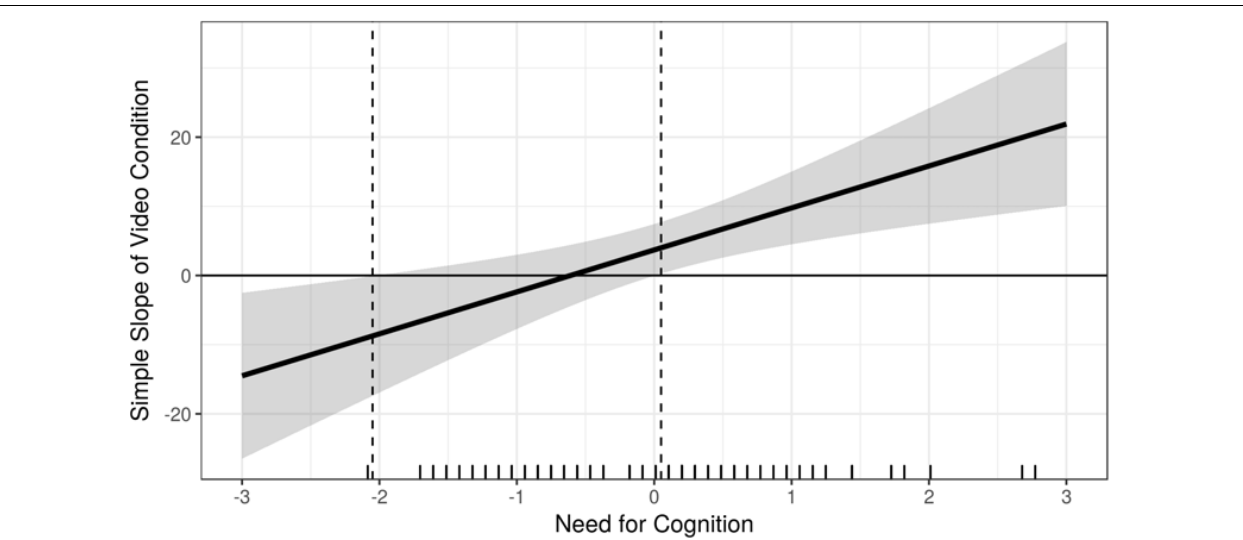
FIGURE 6 | Marginal effects (or regions-of-significance) plot: On the y -axis we depicted the simple slope of video condition on dictator game generosity. On the x -axis we z -transformed Need for Cognition for the purpose of this figure. The simple slope is significant and negative when NFC is –2.05 standard deviations away from the mean or further. 0.85% of observations in NFC are within this region. The simple slope of the elevating video condition on dictator game generosity is significant and positive when NFC is 0.05 standard deviations away from the mean or further. 38.98% of observations in NFC are within this region. The results depicted are those using the trimmed sample, N =